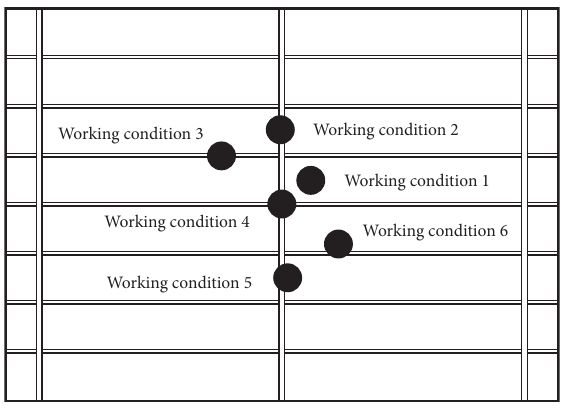
Figure 3: Missile Table 4: Schedule of work.